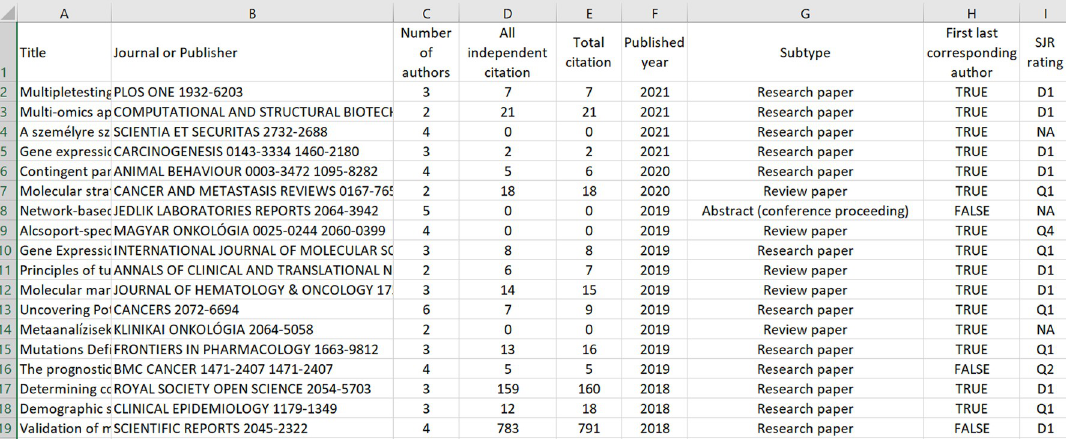
Fig 6. The complete publication record for a researcher as assembled by the scientomteric.org site. In addition to the title, the name of the journal or publisher (in case of book), the number of authors, the number of citations received, publication year and type, lead authorship, and SCImago journal rank are provided. The table delivers an opportunity to control and validate the computation of the scoring